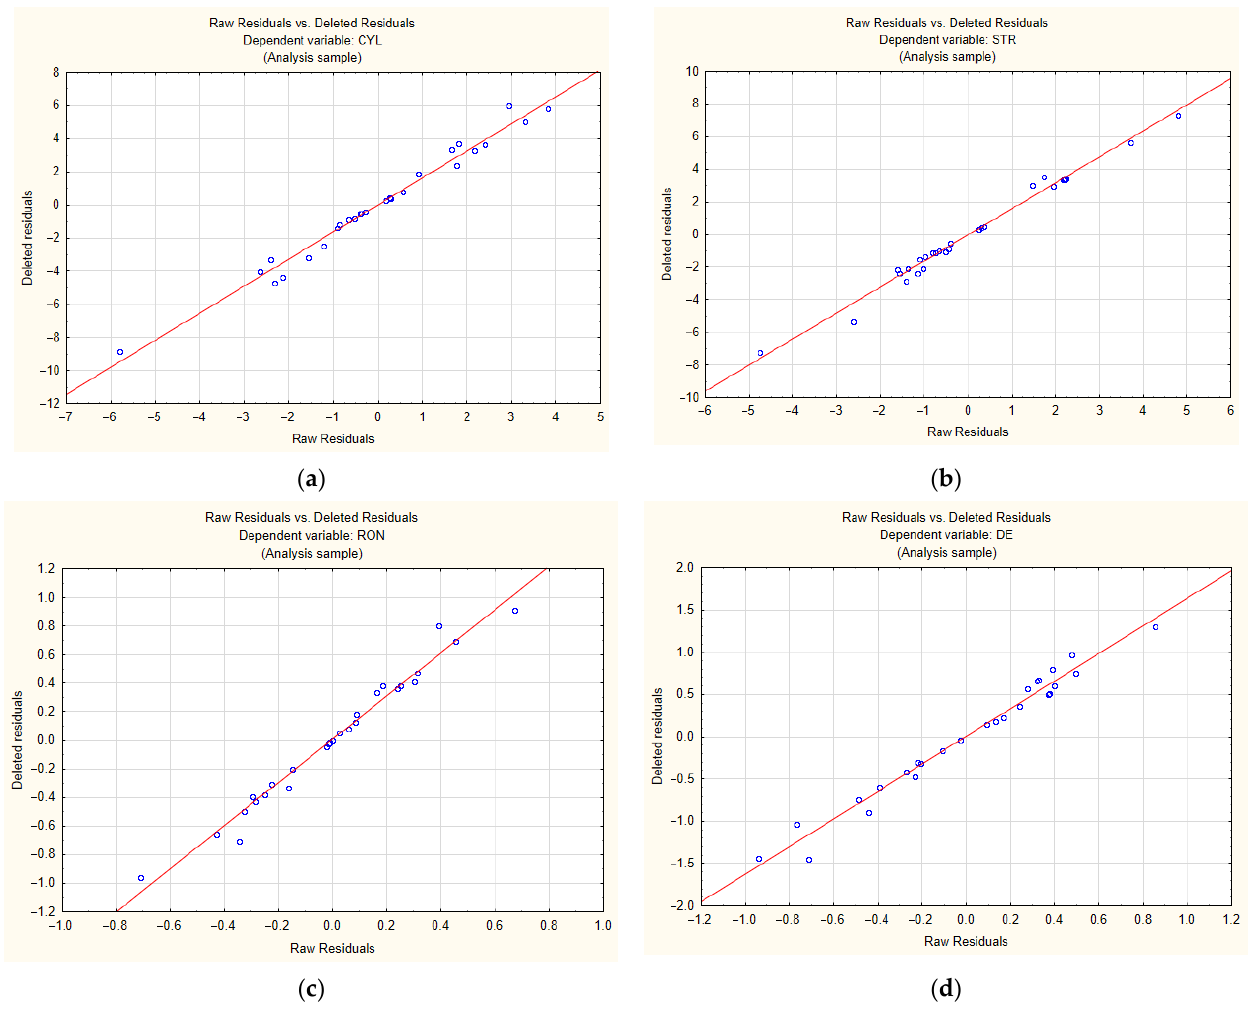
Figure 5. Normal Probability plots for: ( a ) cylindricity error; ( b ) straightness error; ( c ) roundness error; ( d ) diameter error.